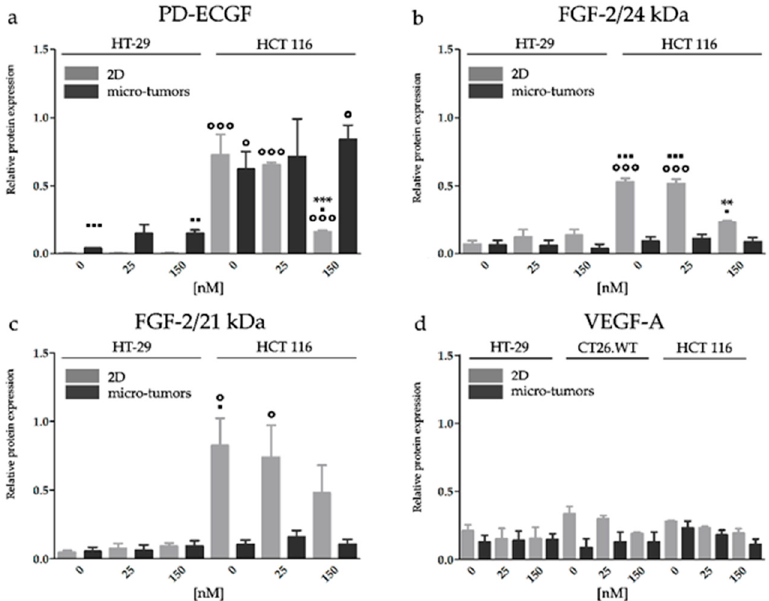
Figure 5. Effect of HY-PDT on the pro-angiogenic factor gene expression of PD-ECGF ( a ), FGF-2 ( b ), VEGF-A ( c ), PDGF-A (V1) ( d ), and PDGF- A (V2) ( e ). The mRNA was quantified by RT-qPCR and normalized to the expression of phosphomannomutase 1 ( PMM1 ). All results are expressed as the mean value of at least two independent experiments ± SD. The groups treated with HY-PDT were compared with untreated control (* p < 0.05, ** p < 0.01, *** p < 0.001). The experimental micro-tumors and cells cultivated in 2D cell model were compared with each other ( ▪ p < 0.05, ▪▪ p < 0.01, ▪▪▪ p < 0.001). Data were analyzed with one-way ANOVA with Tukey´s post-test or t -test.